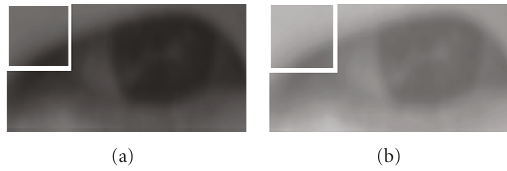
Figure 3: Two eye images from the same subject with di ff erent